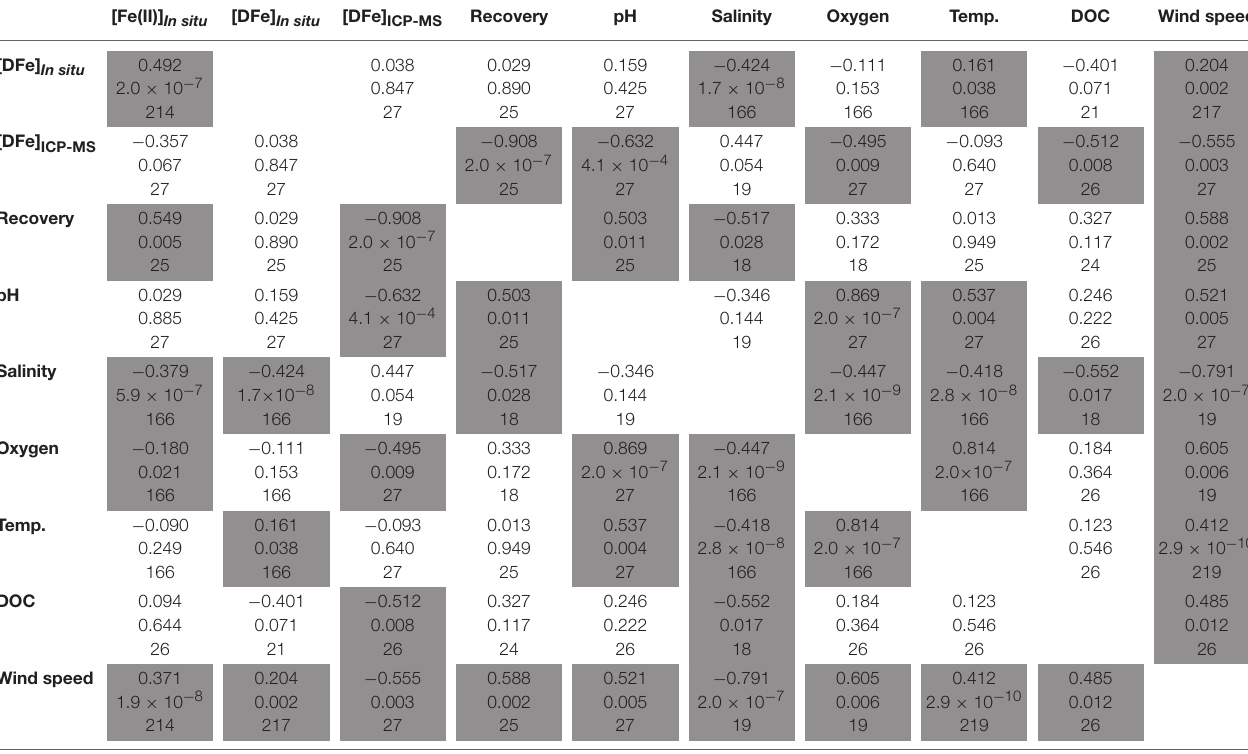
TABLE 1 | Spearman’s correlation, variables which correlate/anti-correlate ( P < 0.05) are highlighted. [Fe(II)] In situ [DFe] In situ [DFe] ICP-MS